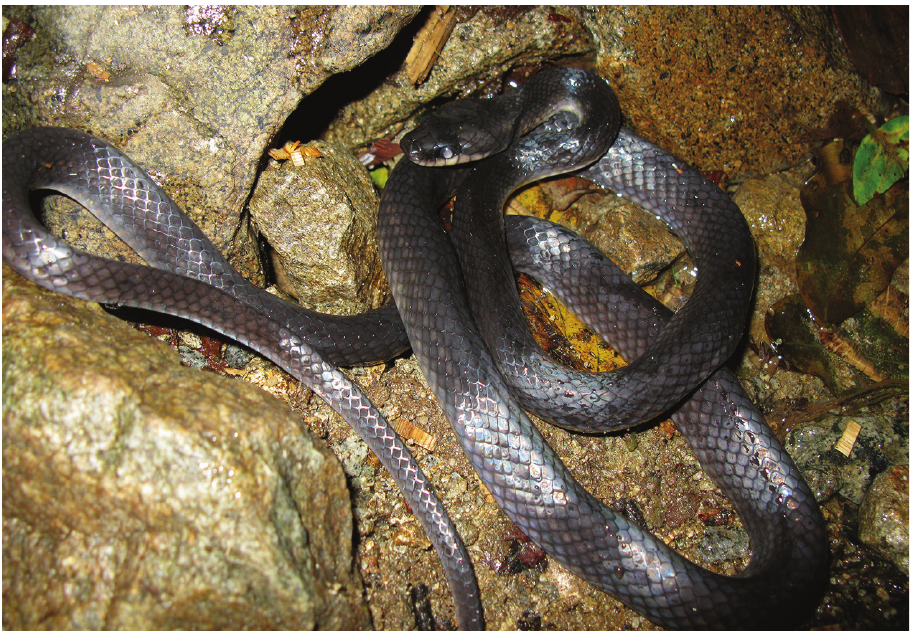
Figure 71. Stegonotus muelleri (KU 320004) from Mt. Magdiwata, Barangay Bayugan II, Municipality of San Francisco, Agusan del Sur Province. Photo: ACD.